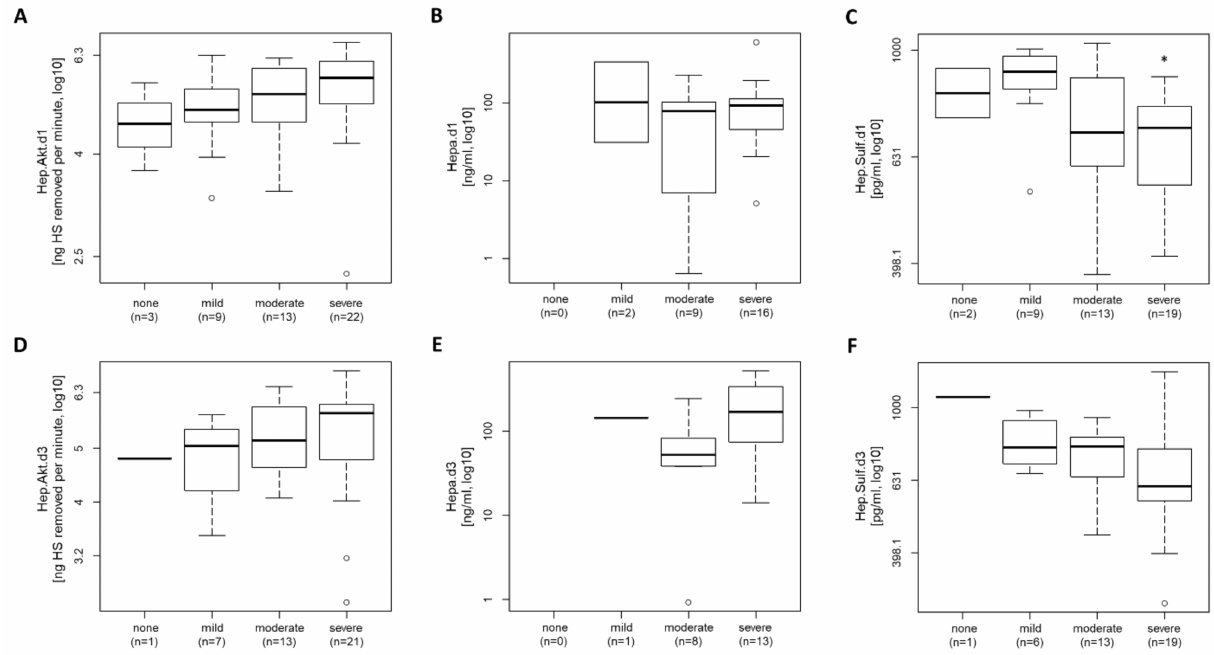
Figure 1. Heparanase activity, heparanase level, and heparan sulfate level in COVID-19 patients in relation to the severity of ARDS. Boxplot of heparanase activity on ( A ) day 1 and ( D ) 3 and heparanase level on ( B ) day 1 and ( E ) 3, as well as the heparanase sulfate level on ( C ) day 1 and ( F ) 3 of COVID-19 patients in relation to the severity of ARDS (none, mild, moderate, or severe ARDS) are shown. The untransformed data are presented as a boxplot. The lines inside the boxes represent the median, and the box is defined by the range of Q1 and Q3. Circles outside the box are values represent outliers. For statistical analysis, Kruskal–Wallis analysis was used with a significance level of p < 0.05, with the post hoc test indicating which groups showed a statistical difference by TRUE (significant) or FALSE (not significant). * indicates a significant difference between severe and mild ARDS. ARDS: acute respiratory distress syndrome; Hep.Akt.: heparanase activity; Hepa.: heparanase; Hep.Sulf.: heparan